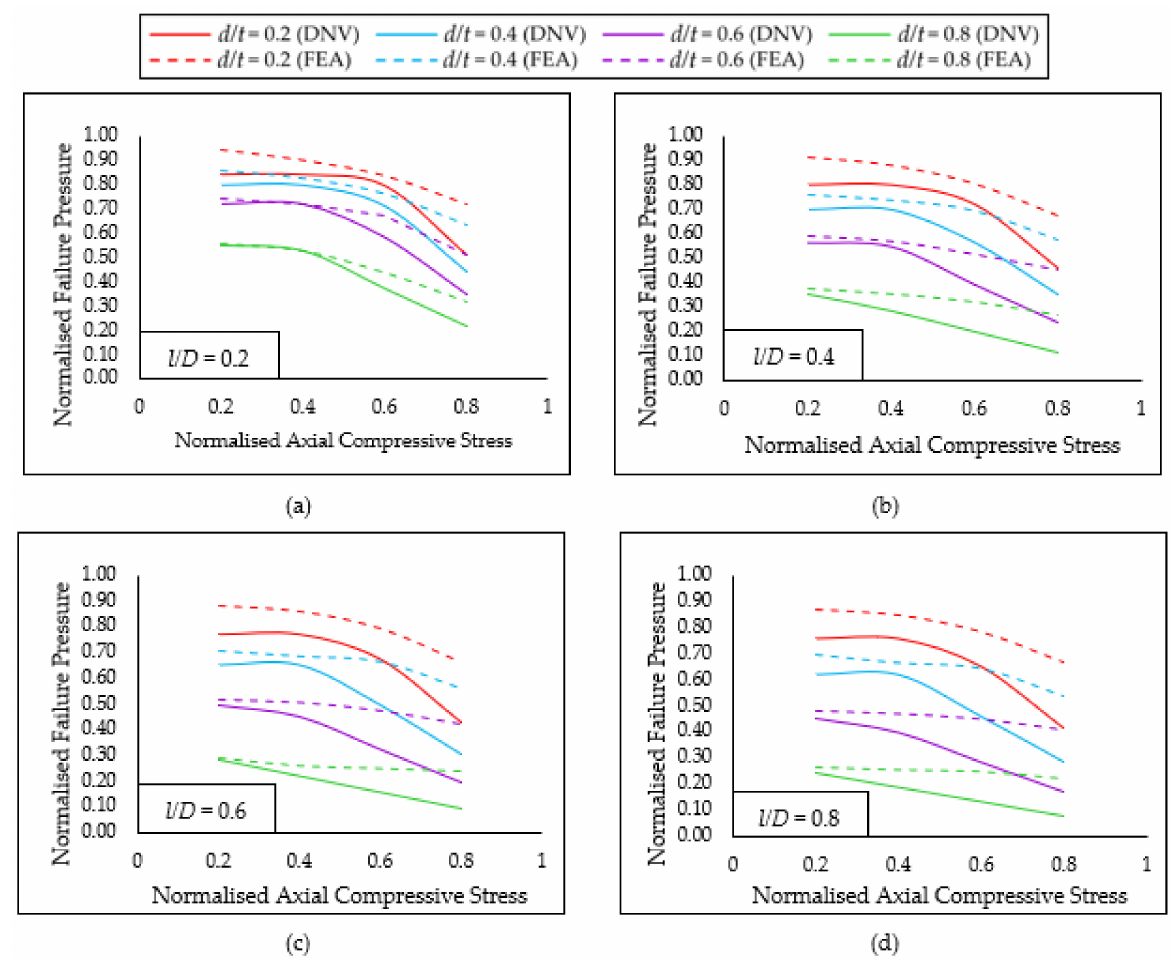
Figure 11. ( a ) Normalized failure pressure predictions of API 5L X80 pipe using FEA and DNV subjected to internal pressure and axial compressive stress for a normalised defect length of ( a ) 0.2; ( b ) 0.4; ( c ) 0.6; and ( d ) 0.8.